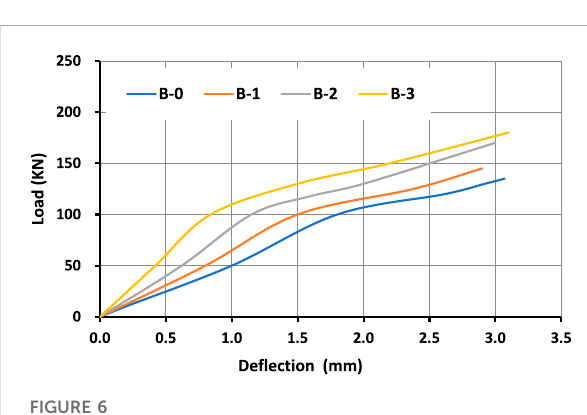
FIGURE 4 Test setup.